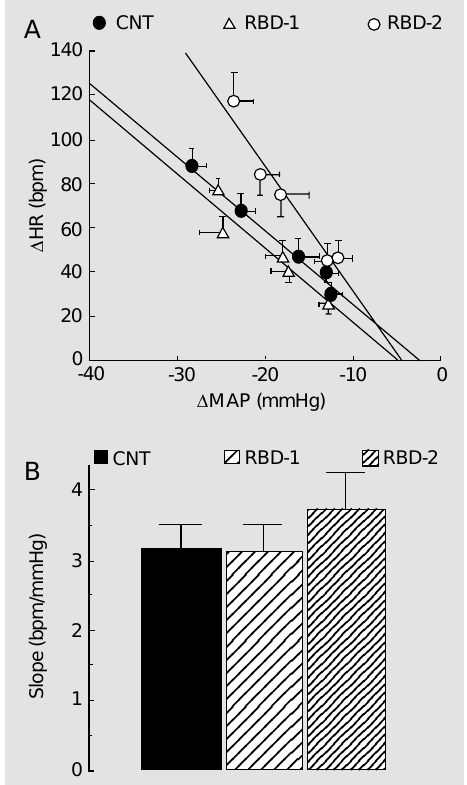
Figure 4 - A , Relationship be- tween changes in mean arterial pressure ( D MAP) and heart rate ( D HR) following increasing bolus doses of sodium nitroprusside in adult rats obtained by feeding dams a standard control diet dur- ing pregnancy and nursing (CNT) or by feeding them the regional basic diet (RBD) during preg- nancy (RBD-1) or during nursing (RBD-2). B , Average slopes of the sodium nitroprusside re- sponse in the above three groups. Vertical and horizontal bars indicate the SEM (N = 8-9 rats per